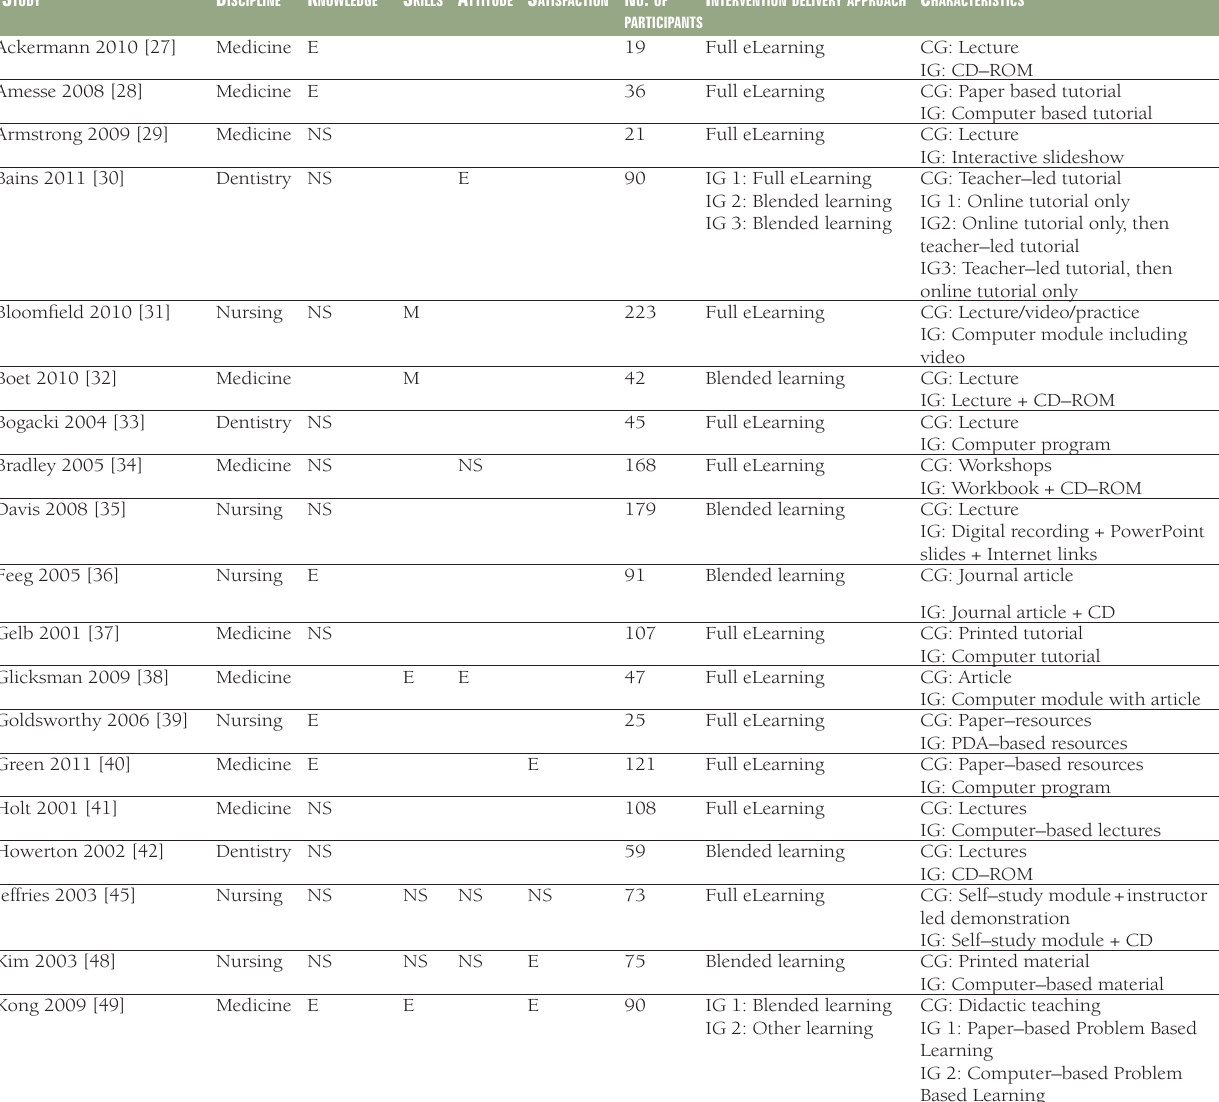
Table 2. Summary of findings for the 40 studies comparing offline eLearning with traditional learning S tudy d